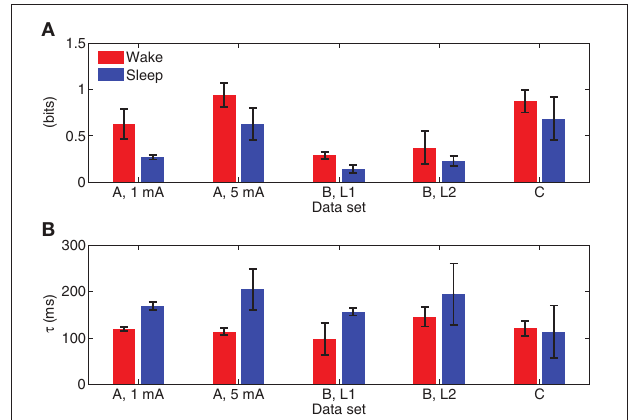
FIGURE 12 | (A) Average maximum values of integrated information with error bars indicating one standard error. (B) Average lag at which maximum integrated information is achieved, with error bars indicating one standard error.